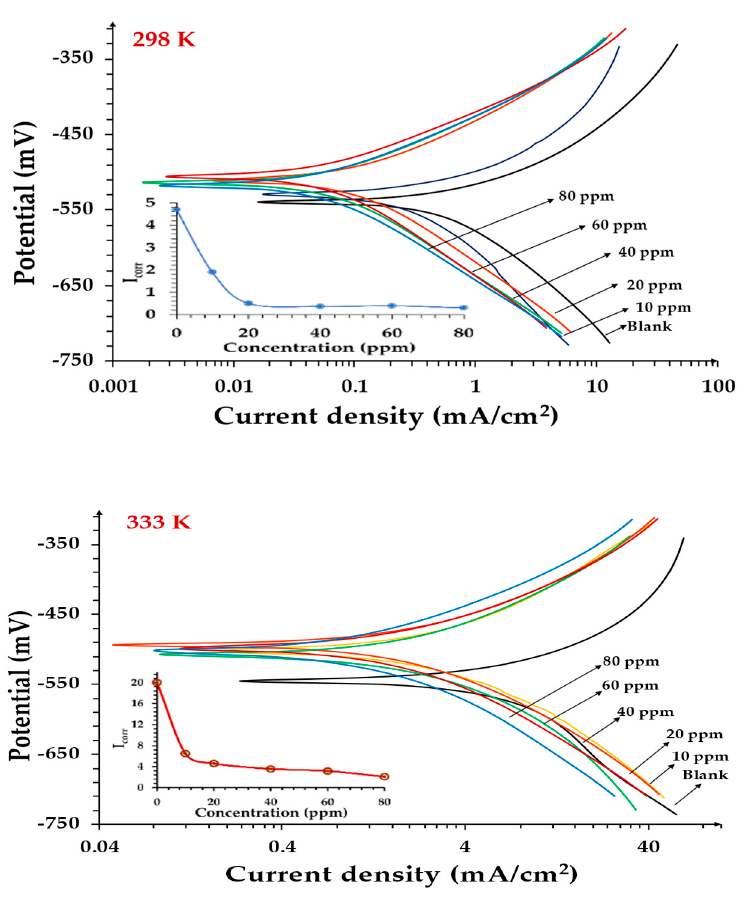
Figure 9. PDP plots of low-carbon steel corrosion in 1 M HCl in the absence and presence of CoO/Co 3 O 4 NPs at 298 and 333 K. Table 3. PDP parameters of low-carbon steel corrosion in 1 M HCl in the absence and presence of CoO/Co 3 O 4 NPs at 298 and 333 K.